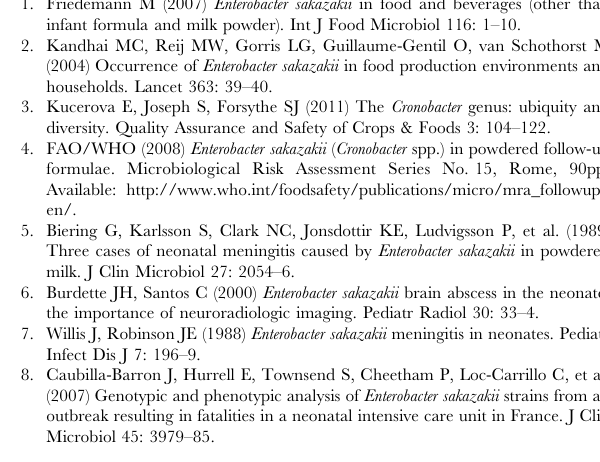
Figure S1 BLAST Ring Image Generator (BRIG) analy- sis of the Cronobacter genomes. Figure S2 BLAST Ring Image Generator (BRIG) analy- sis of Cronobacter plasmid pESA3 with matching sequence content found in other Cronobacter species. Figure S3 BLAST Ring Image Generator (BRIG) analy- sis of Cronobacter plasmid pCTU1 to matching content in other Cronobacter species. Table S1 Number of putative prophage regions in the Cronobacter genomes. Table S2 Presence ( + ) or absence ( 2 ) of type six secretion systems in Cronobacter spp. Table S3 Copy number variation of the hemolysin gene within the Cronobacter genus. Text S1 Additional regions of variation between Crono- bacter